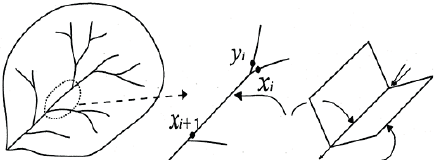
Fig. 1 Unit channels and unit